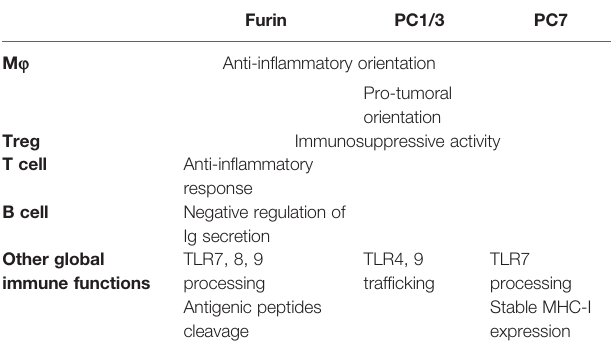
TABLE 2 | Summary of functions of PCs in the immune